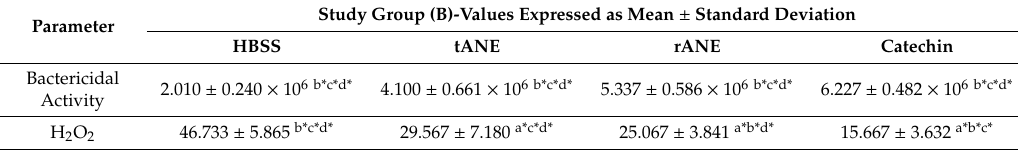
Table 4. Post-hoc analysis of microbiological (bactericidal activity) and biochemical (hydrogen peroxide) parameters for group (B)—chronic periodontitis.